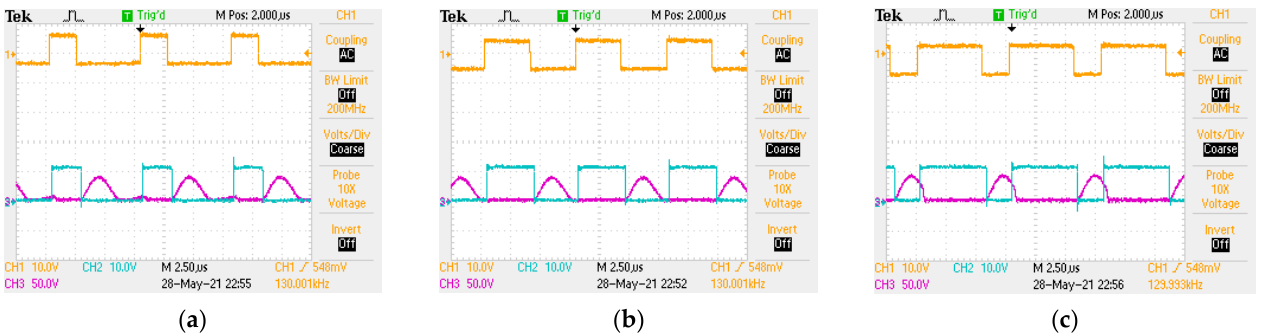
Figure 13. Waveform across the shunt capacitor for duty cycle ( a ) D = 0.3, ( b ) D = 0.5, ( c ) D = 0.7.